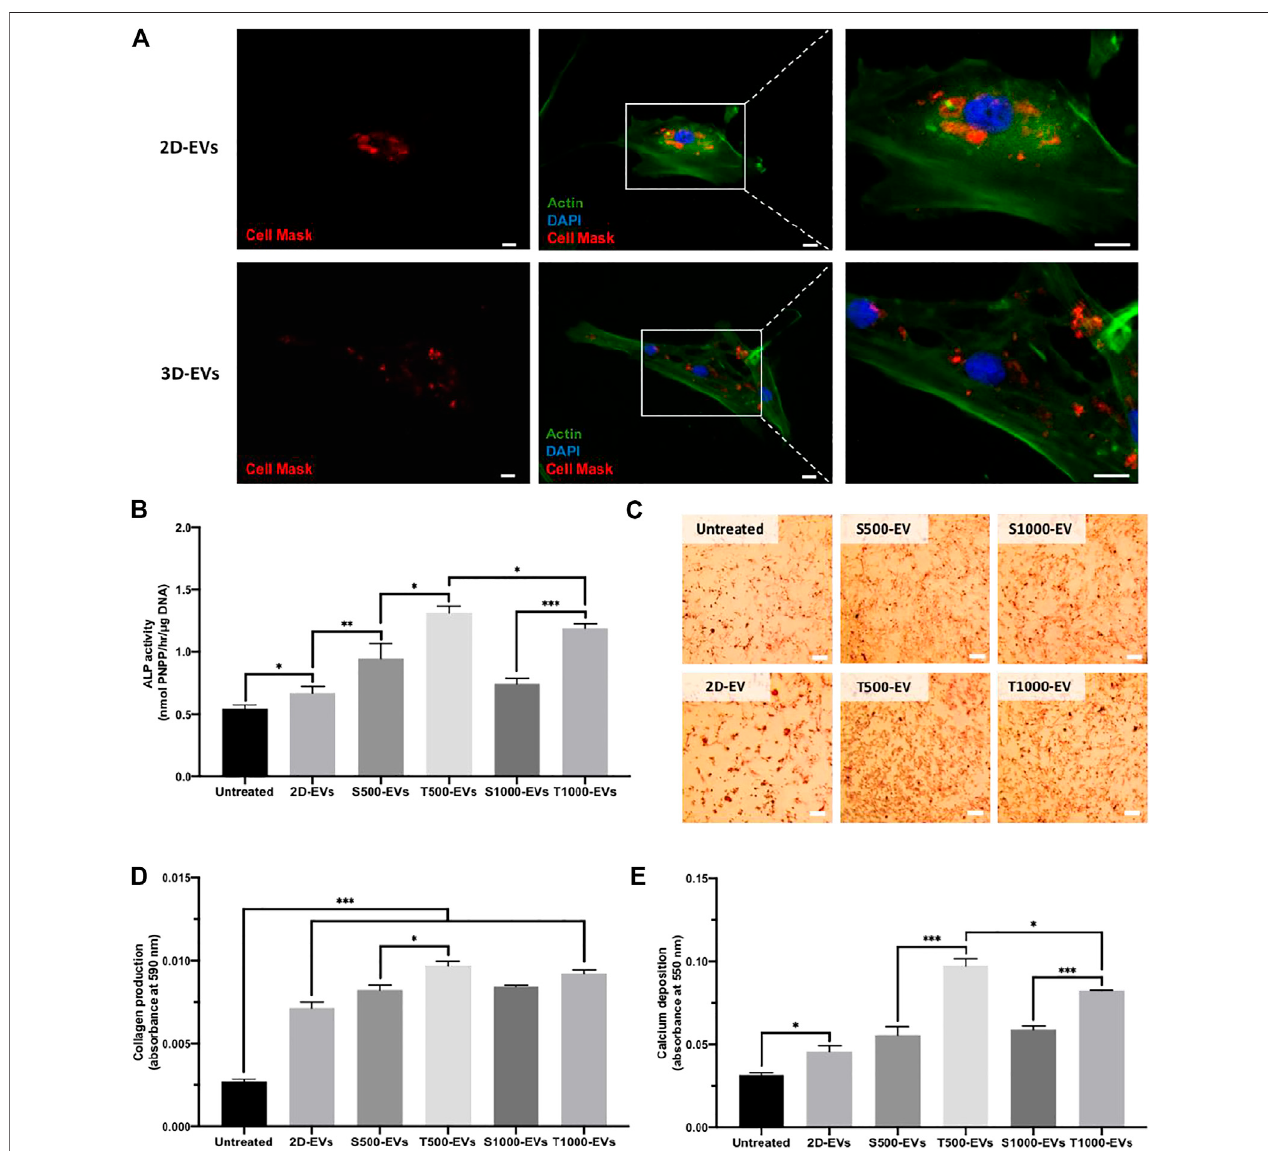
FIGURE5| Effect ofscaffold-derivedosteoblastEVsonhBMSC ’ sosteogenicdifferentiationandmineralisation. (A) Osteoblast-derivedEVcelluptake.Scalebar (cid:2) 20 µm. (B) ALP activity, (C,D) collagen production (E) calcium deposition following 21 days osteogenic culture. Scale bar (cid:2) 200 µm. Data are expressed as mean ± SD (n (cid:2) 3). *P ≤ 0.05, **P ≤ 0.01 and ***P ≤ 0.001.